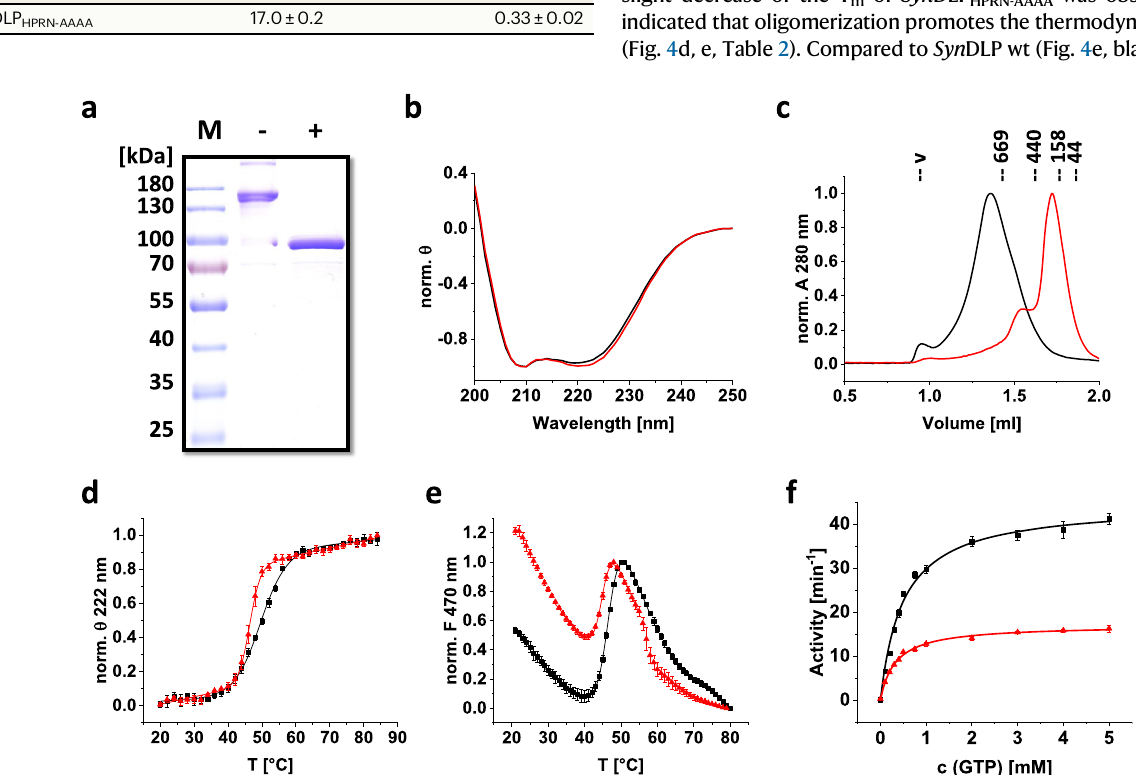
Fig.4|Biochemicalanalysisof Syn DLP HPRN-AAAA .a Puri fi ed Syn DLP HPRN-AAAA was analyzed via SDS-PAGE in the presence of 0.1mM DTT (lane − ) or 100mM DTT (lane +). The calculated molecular mass of the protein is 93kDa. The SDS-PAGE analysis revealed a single band at ~100kDa (lane +) without showing further protein bands, thus the protein was ≥ 95% pure. M=marker.Representativegel of two independent experiments showing the same results. b CD spectra of Syn DLP wt(black)and Syn DLP HPRN-AAAA (red). Themean ofthreemeasurementsisshown. Thespectrawerenormalized( θ valueat250nmsetto0,minimum θ setto − 1)for better comparison. c Analytical size exclusion chromatography of Syn DLP wt (black) and Syn DLP HPRN-AAAA (red). The elution peak positions of the standard proteins and the corresponding molecular masses are indicated (v = void volume). A